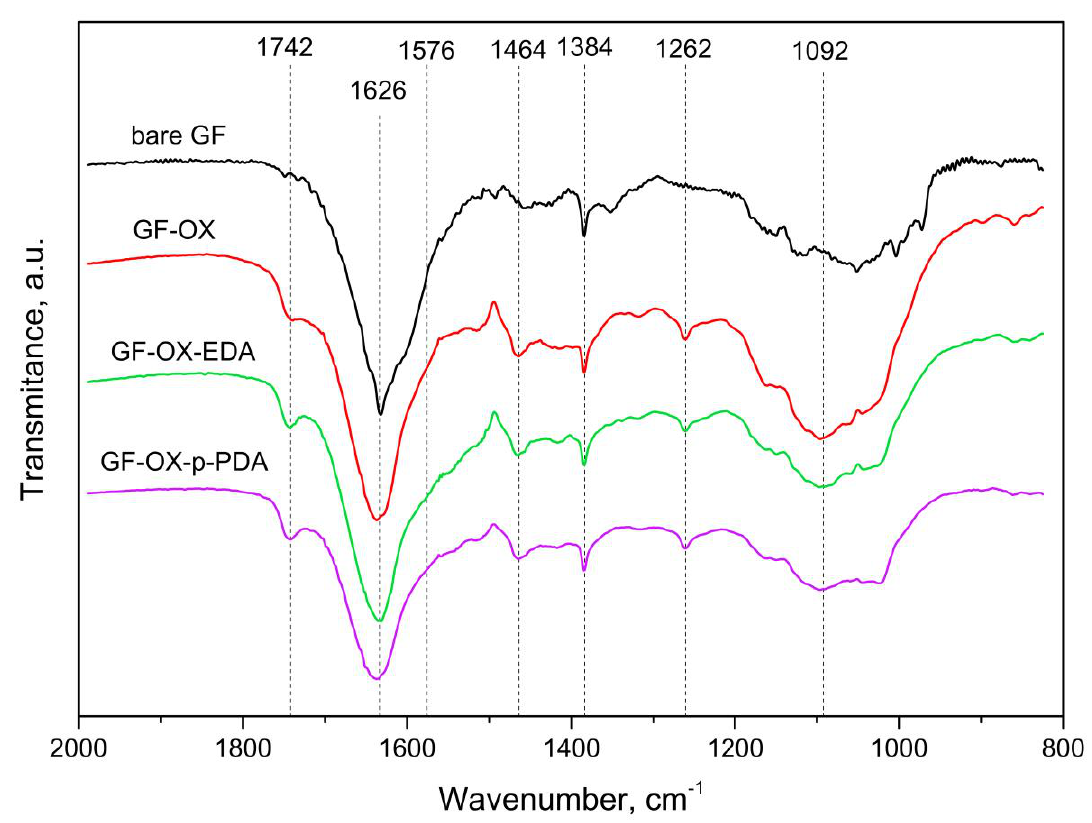
Figure 2. Fourier-Transform Infrared (FT-IR) spectra of bare GF, electrochemically oxidized (GF-OX) and modified with ethylenediamine (EDA) (GF-OX-EDA) and pPDA (GF-OX-pPDA).